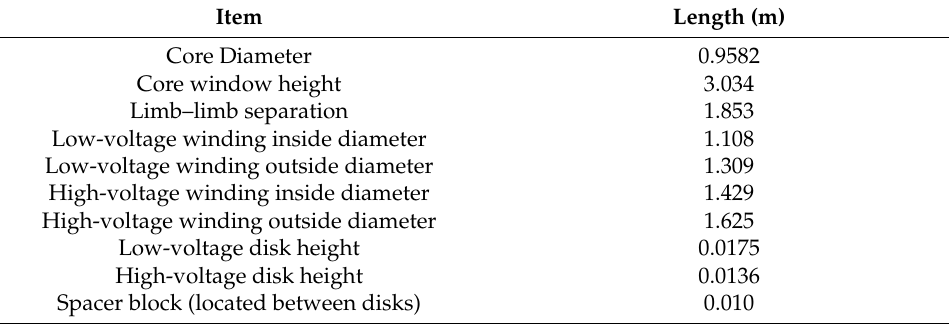
Table 2. Transformer internal